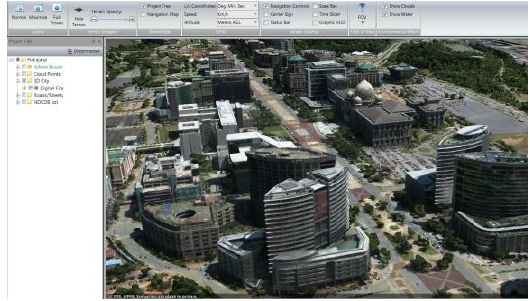
Figure 2 A snapshot of SKiP 3D View of FT Putrajaya